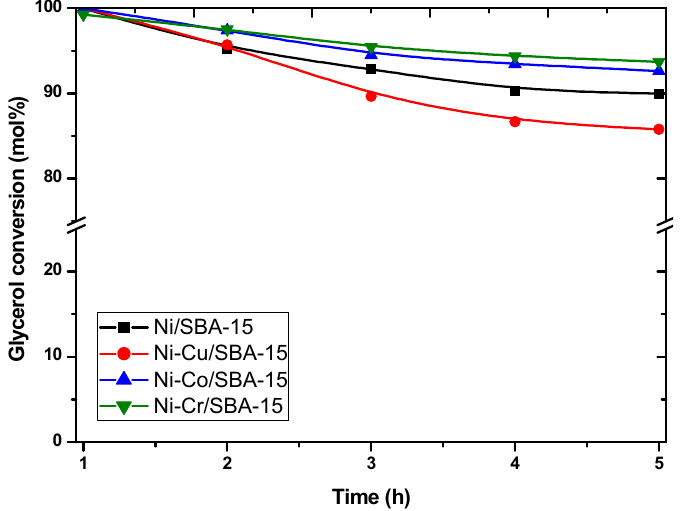
Figure 6. Conversion of glycerol over the Ni-(Cu,Co,Cr)/SBA-15 catalysts ( T = 600 °C, P = 1 bar, WHSV glycerol = 7.7 h − 1 ; water/glycerol = 6 mol/mol).